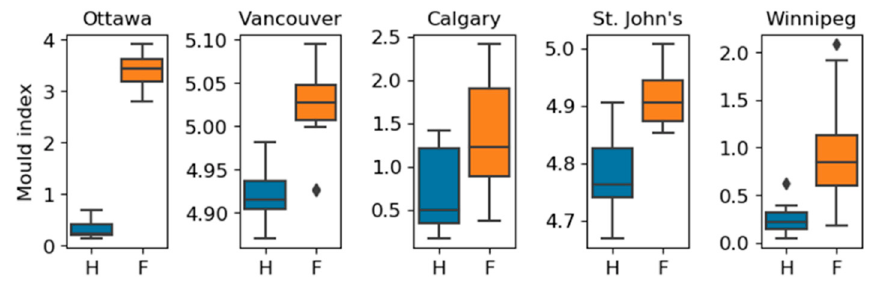
Figure 5. Boxplots of the mean mold index obtained per run under the historical (H) and future (F) time periods in the cities of Ottawa, Vancouver, Calgary, St. John’s and Winnipeg.